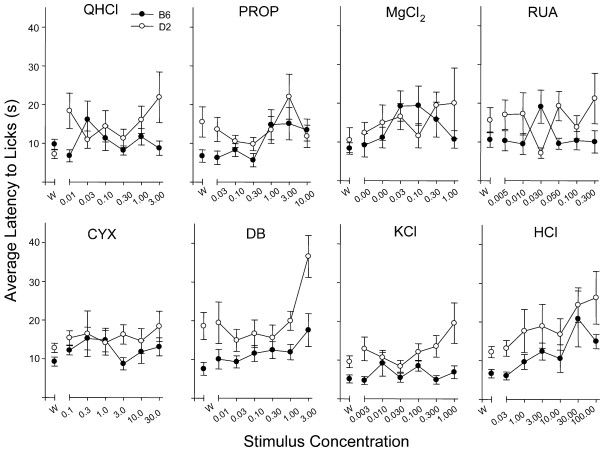
Strain comparison of latency to initiate taste trials of all eight stimuli. W = water trials. Latencies are means (± SE) of the median latencies for individual mice. A significant strain difference was found only for KCl. Effects of concentration were found for DB and HCl.